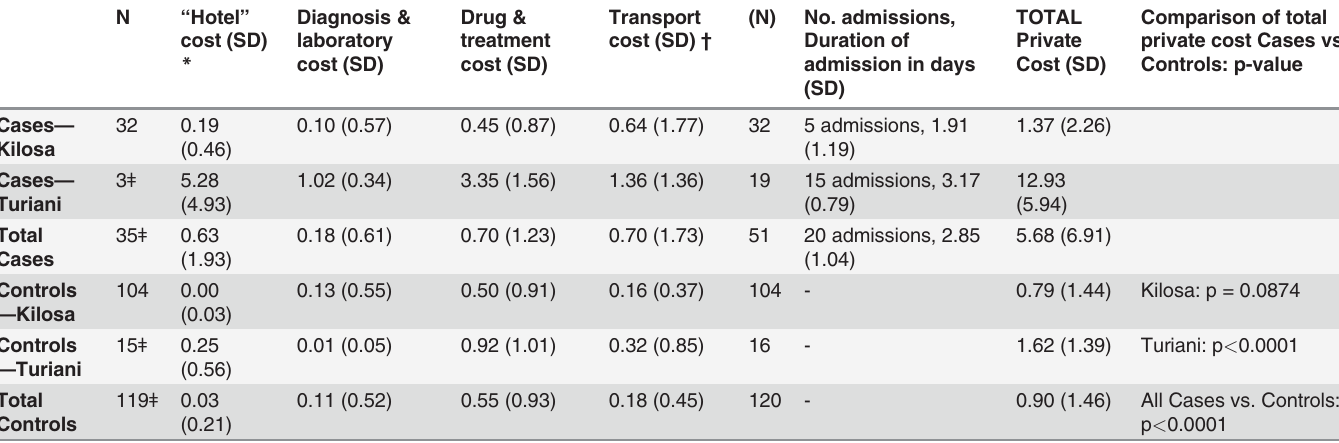
Table 4. Mean private costs (US Dollar) for a whole episode of an acute febrile illness by case-control status and